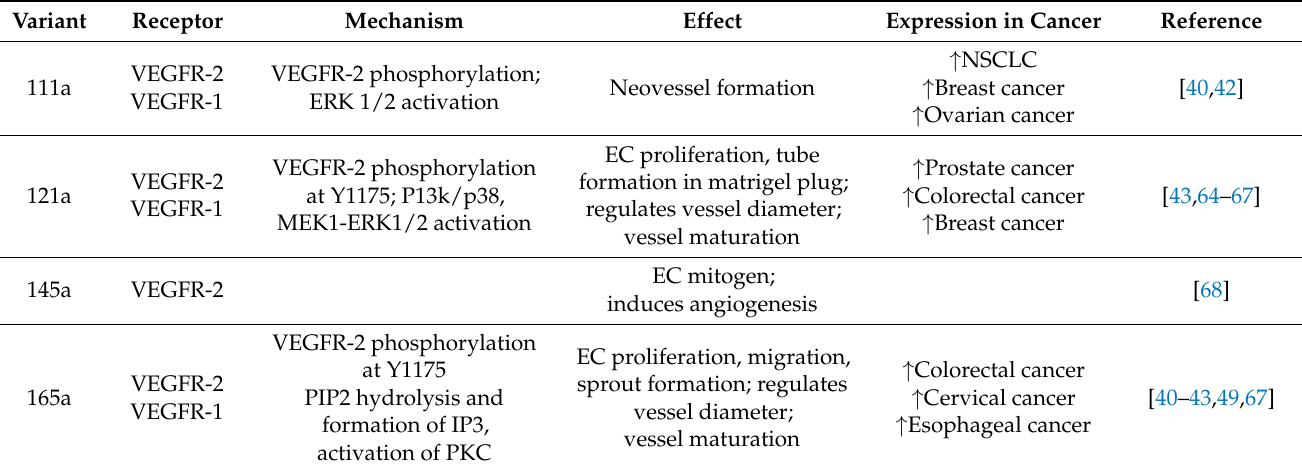
Table 1. VEGF variants that are commonly expressed in human